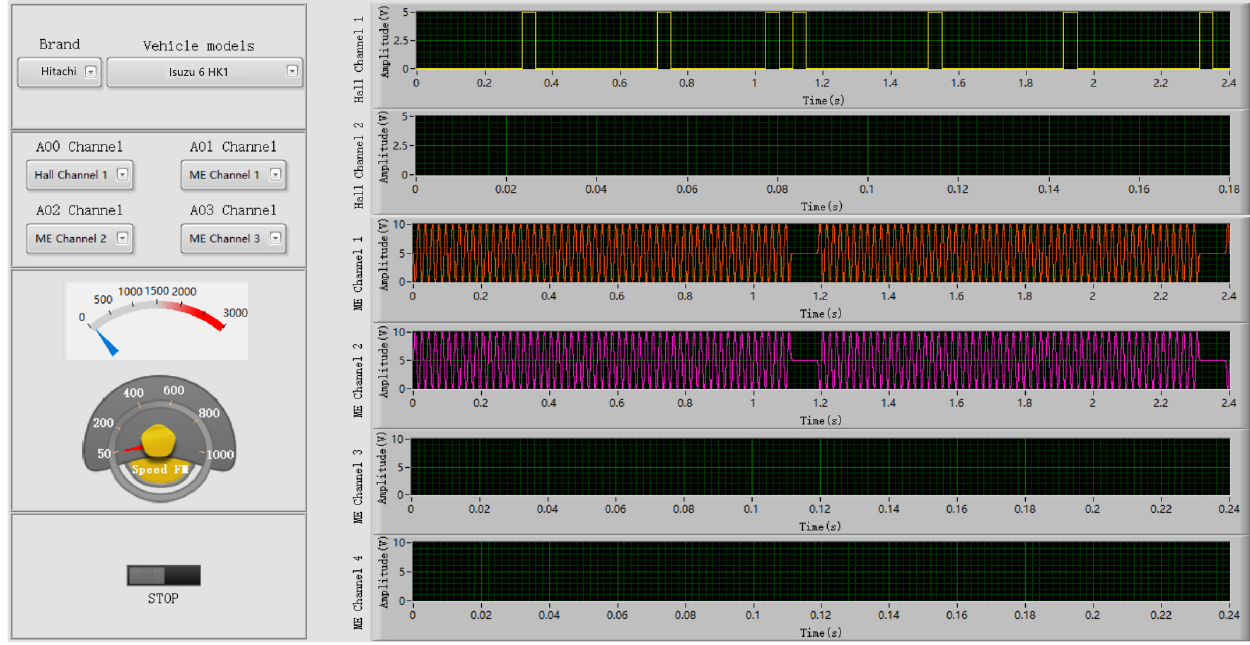
Figure 16. The main interface of signal generator software.